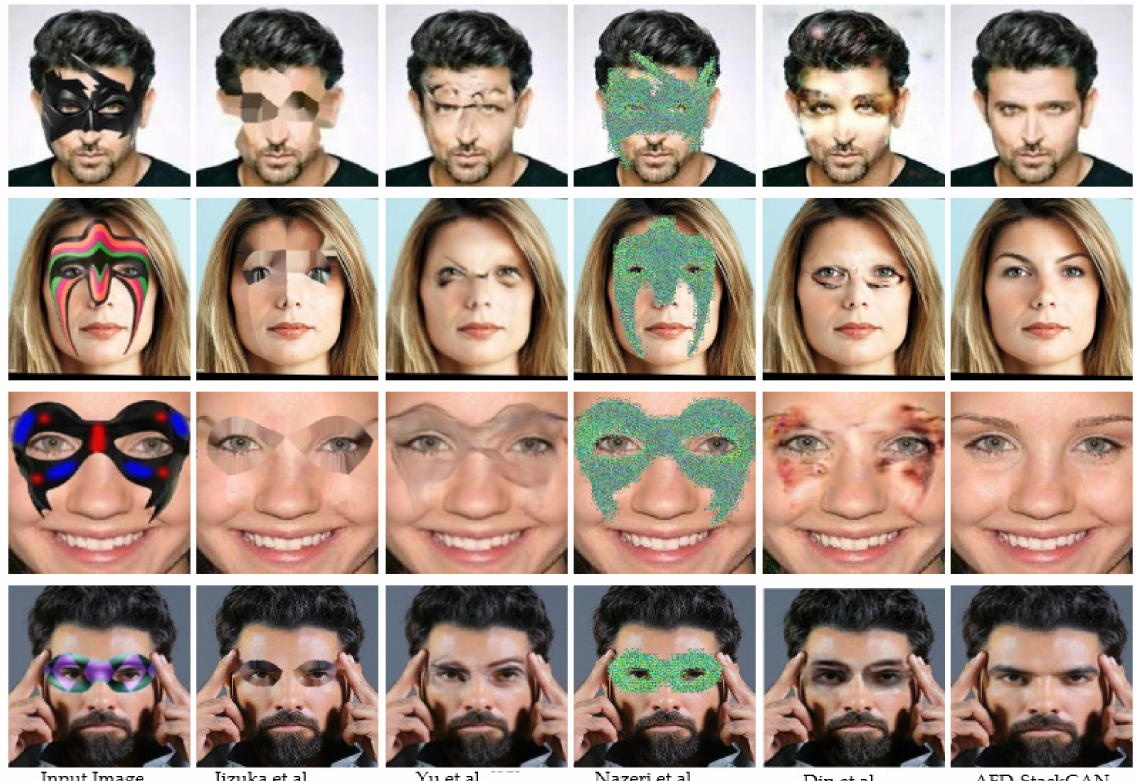
Figure 6. Visual assessment of the proposed AFD-StackGAN with the baseline models on real-world images.